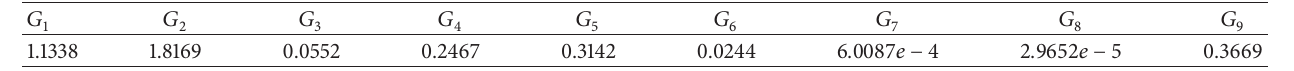
Table 2: Constants of the equation of motion of the gyro-beam system in SI